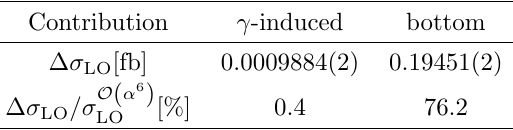
Table 2. LO cross-section contributions (cid:1) (cid:27) LO for pp (cid:22) + (cid:22) (cid:0) e + (cid:23) e jj+ X with initial-state photons ! or external bottom quarks. The photon-induced contributions involve one or two initial-state pho- tons and contribute to the orders . The \bottom" contributions are of the order O and ( (cid:11) 2 (cid:11) 4 ), and involve bottom quarks in the initial and/or (cid:12)nal state. All contributions s O O are given in fb as well as relative to the LO EW cross section of order (in percent). The O digits in parentheses indicate the integration errors. (cid:0)